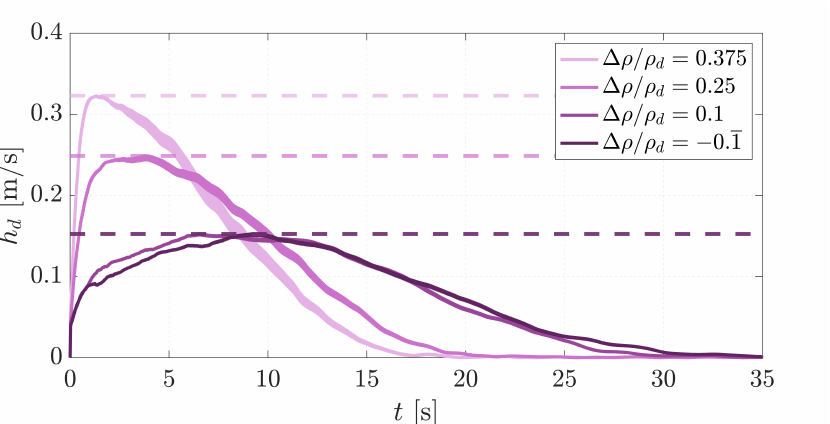
Figure 9. The time derivative of the center of mass of the dispersed phase ˙ h d . The horizontal lines, with the same color code as the solid lines, correspond to the respective maxima of ˙ h d .